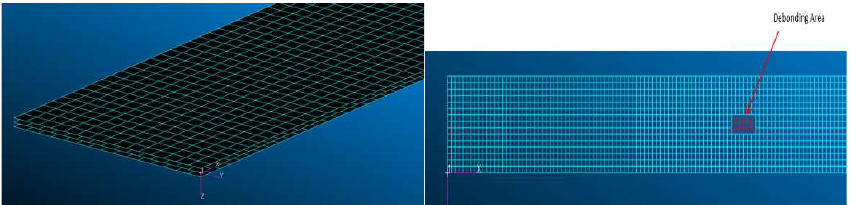
Figure 1. A FE representation of the ASTM Coupon.